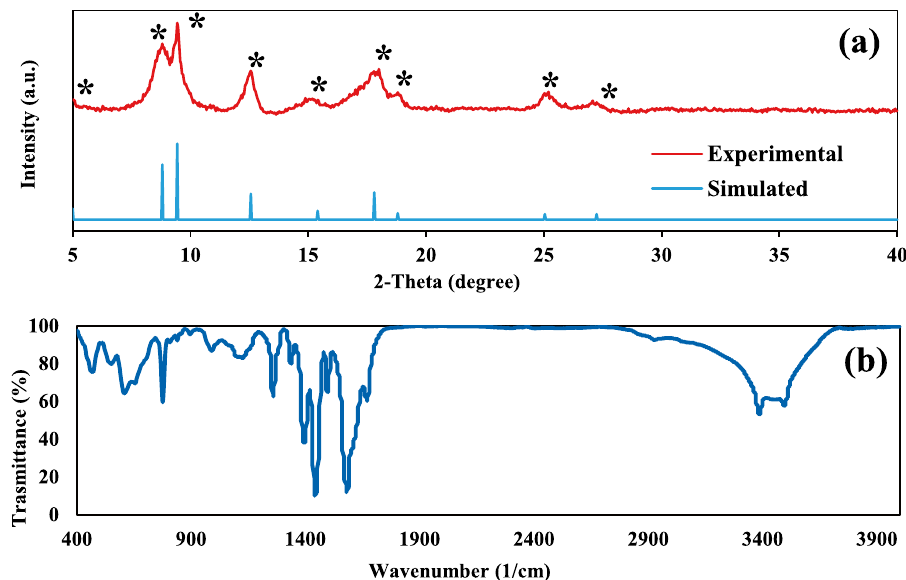
Figure 2. Experimental and simulated XRD patterns of amino-MIL-68(Al) ( a ); FTIR spectra of amino-MIL- 68(Al) ( b